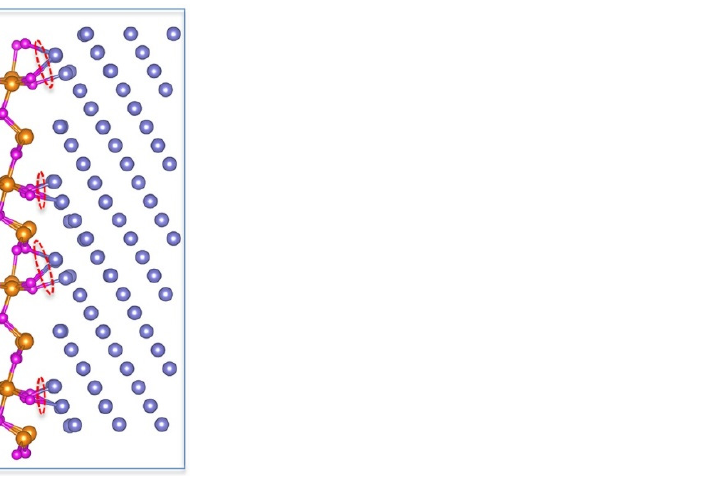
Figure 6. The relaxed atomic structure of model Ι for the β -Ga 2 O 3 /Ir interface as elucidated through first-principles calculation. The red dotted circles indicate the Ir-O covalent bonds between β -Ga 2 O 3 and Ir layers.